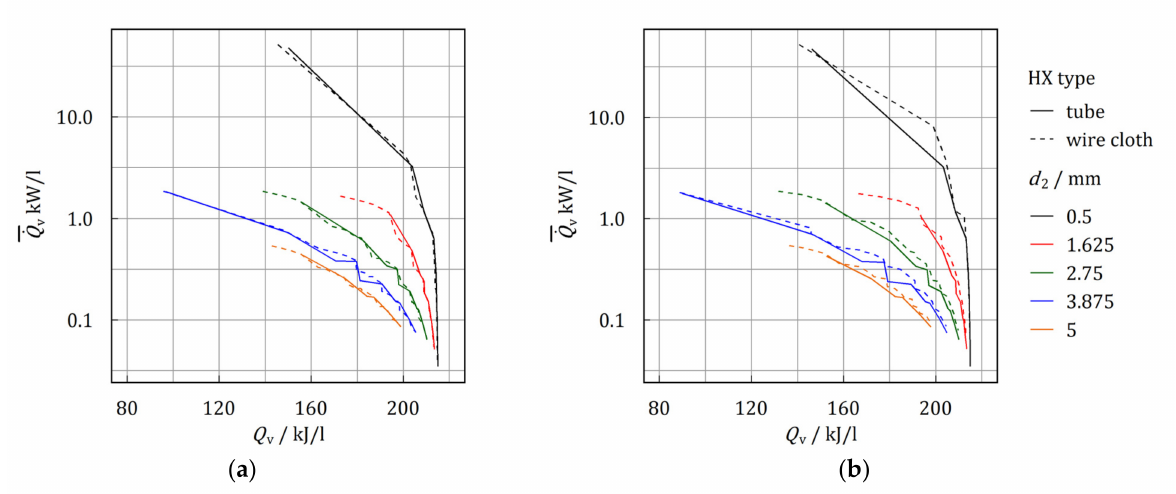
Figure 22. Pareto-optimal configurations of all wire cloth and tube heat exchanger (HX) variations for different tube diameter d 2 for steel ( a ) and aluminum ( b ) of the mean volume specific thermal